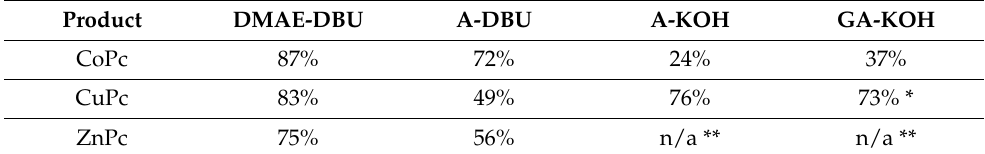
Table 1. Best-yielding reactions for the considered unsubstituted phthalocyanines.